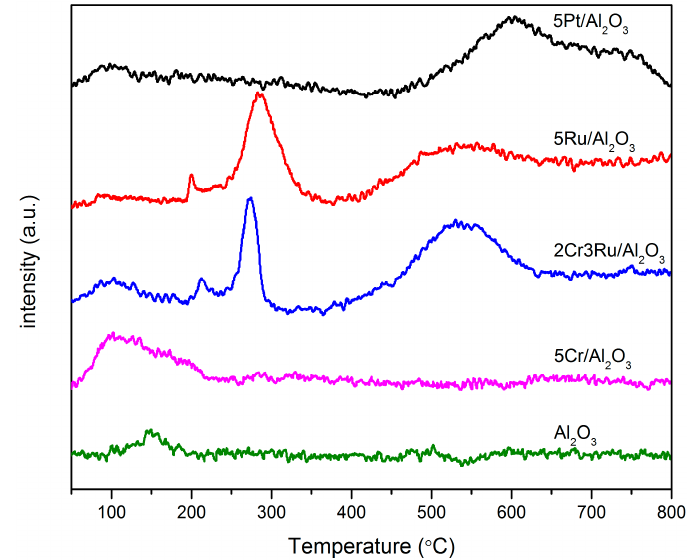
Figure 8. NH 3 -TPD profiles of fresh 5Pt, 5Ru, 5Cr, and 2Cr3Ru supported on Al 2 O 3 , along with bare γ -Al 2 O 3 .